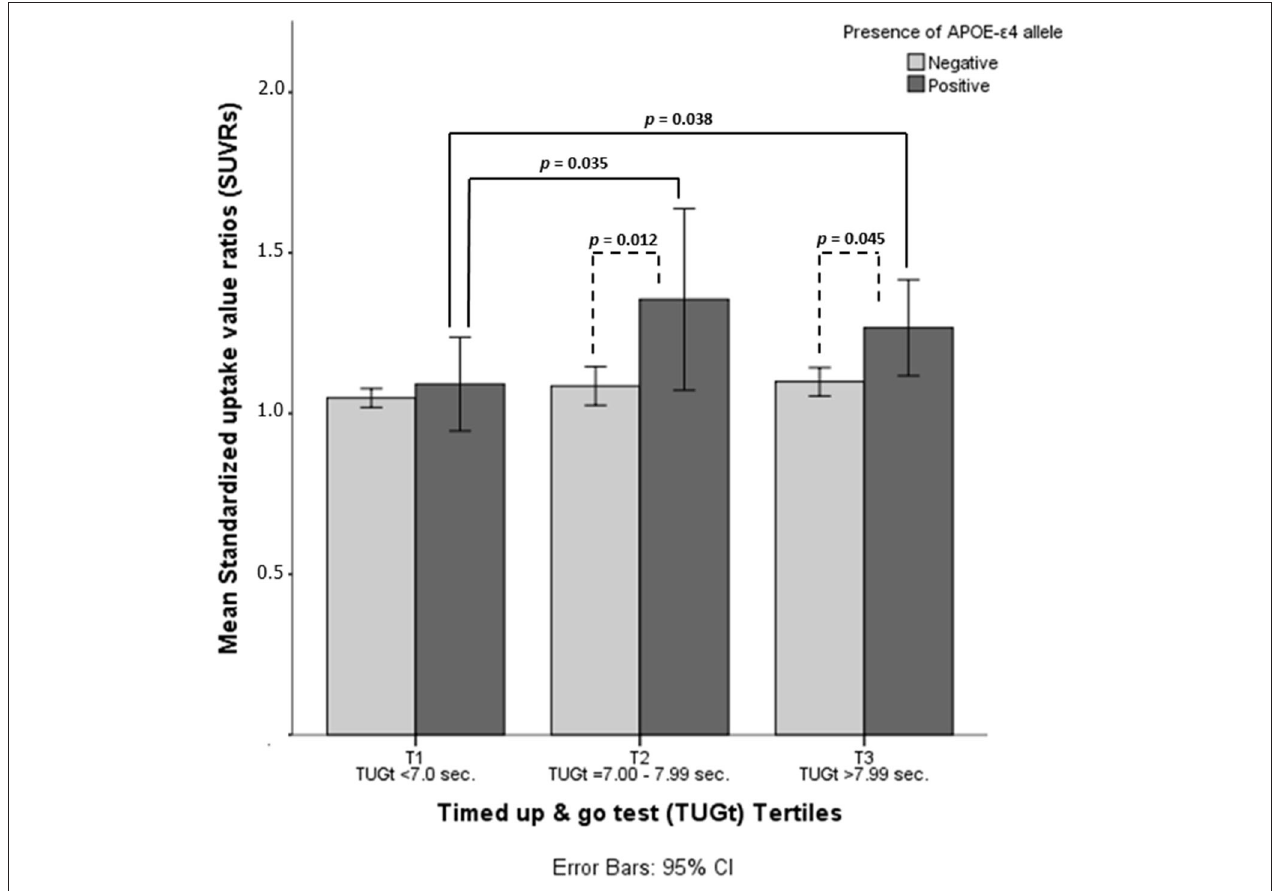
FIGURE 2 | Mean standardized uptake value ratios (SUVRs) according to timed up and go test (TUGt) tertiles and APOE- ε 4